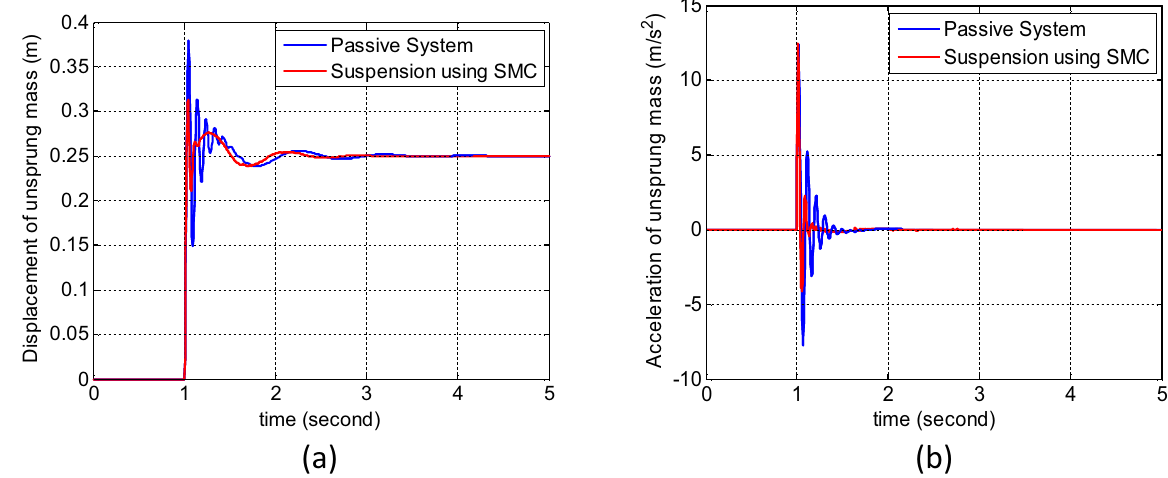
Figure 4: Responses of unsprung mass: ( a ) unsprung mass de fl ection and ( b ) unsprung mass acceleration.